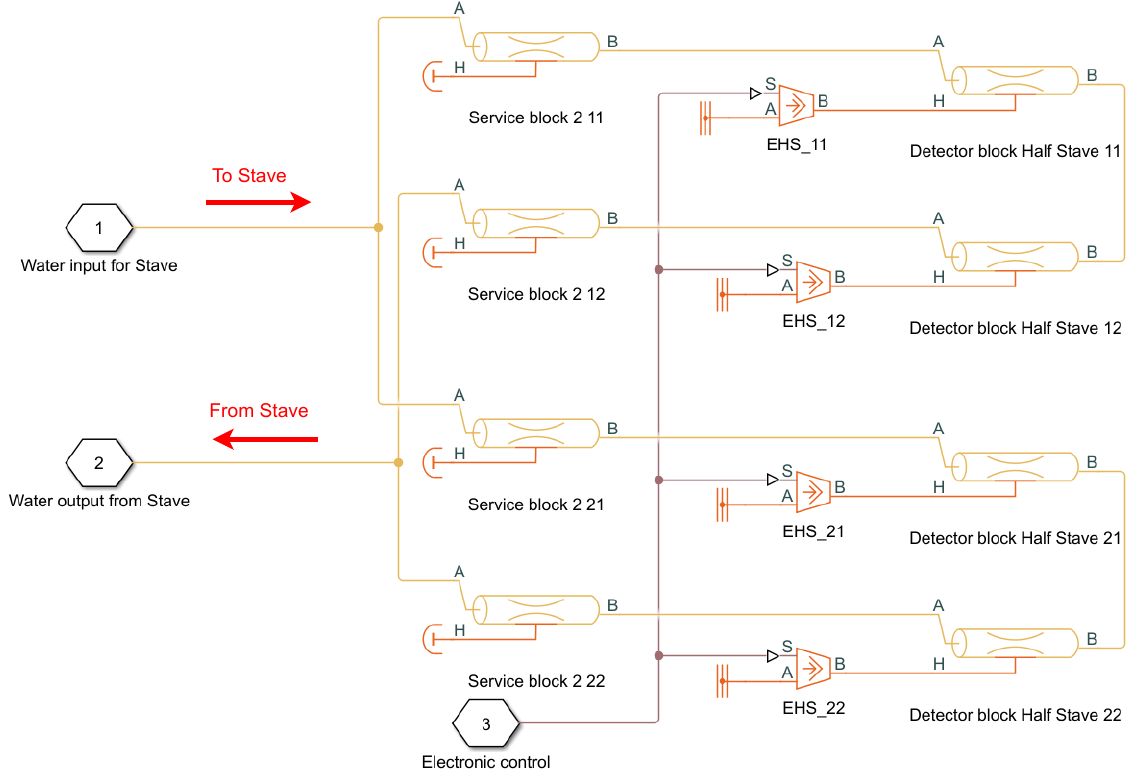
Figure 13. The stave internal structure simulation.